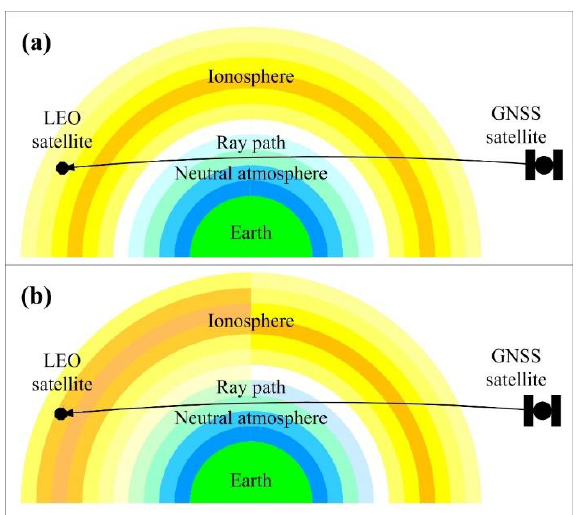
Figure 1. Radio occultation geometry between global navigation satellite system (GNSS) transmitter and low Earth orbit (LEO) receiver satellites, schematically illustrating the signal ray path passing through the ionosphere and the atmosphere, as well as the overall local spherical symmetry assumption ( a ) in contrast to the bi-local spherical symmetry assumption ( b ).